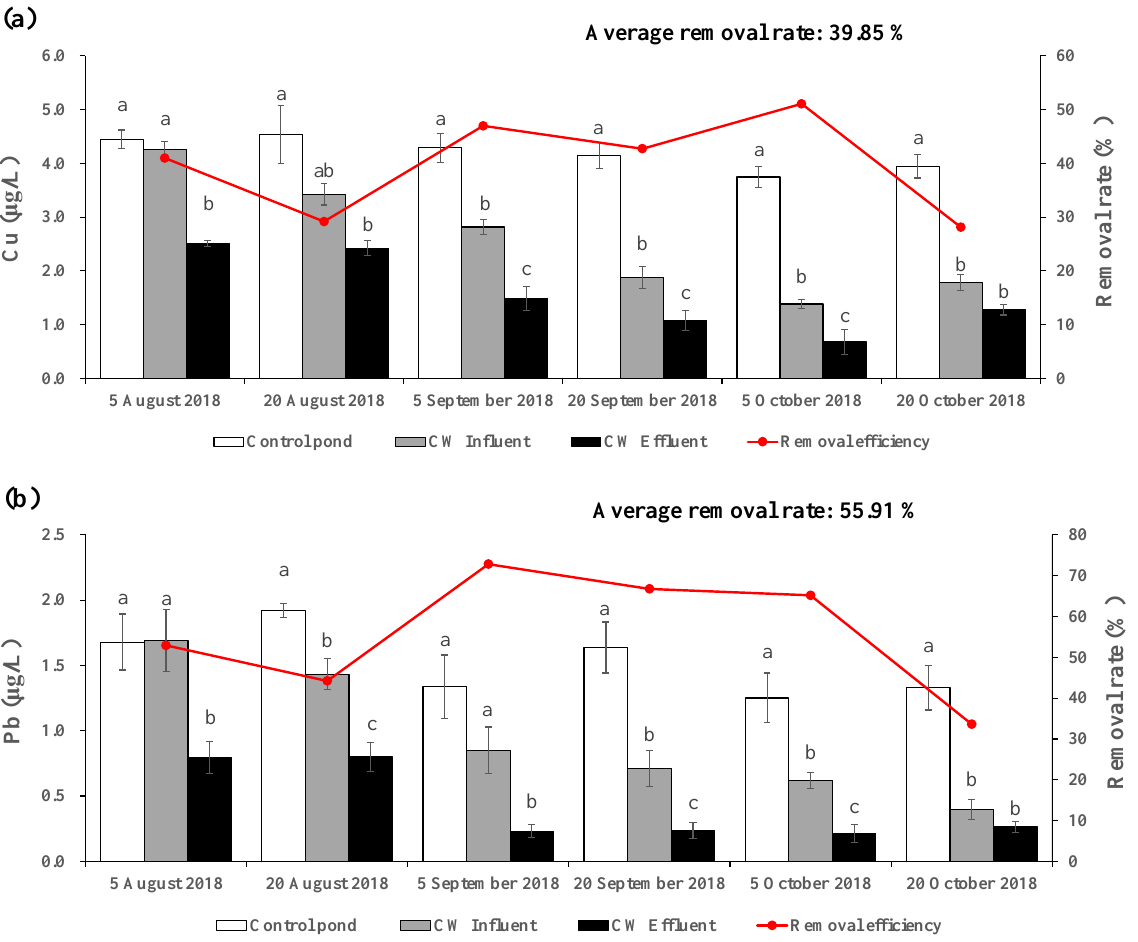
Figure 6. Concentrations of Cu ( a ) and Pb ( b ) in water samples collected from the control pond and the inlet and outlet of CW, and the removal efficiency during the monitoring period. The value is expressed as mean ± SE ( n = 6), and different small letters in bar graphs indicate significant differences ( p < 0.05) among the control pond, CW influent and CW effluent.